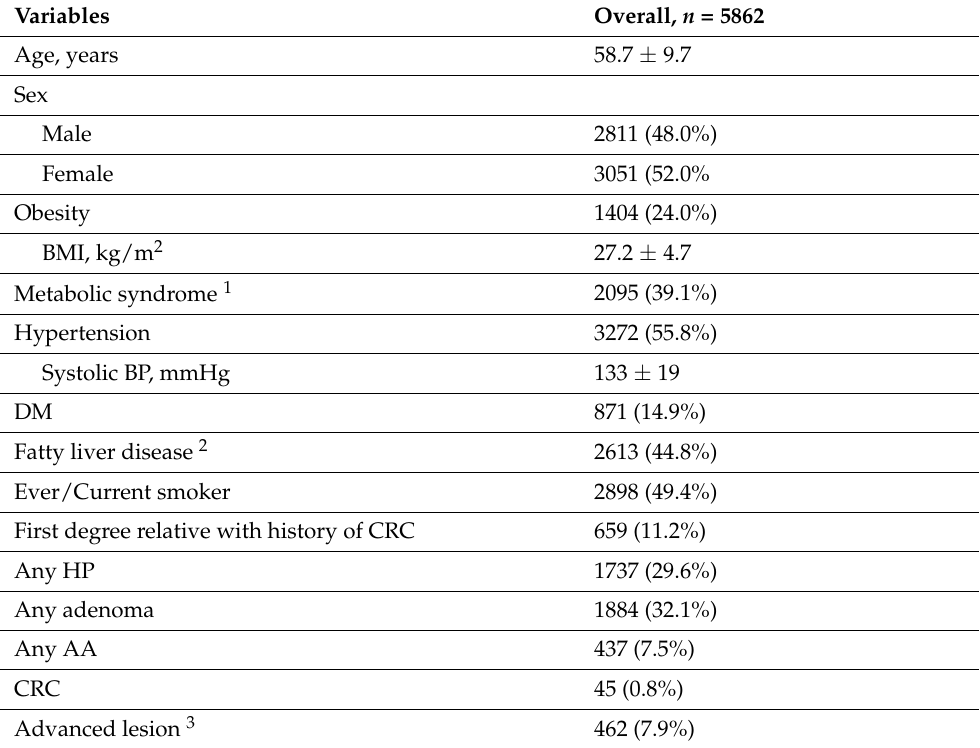
Table 1. Patient